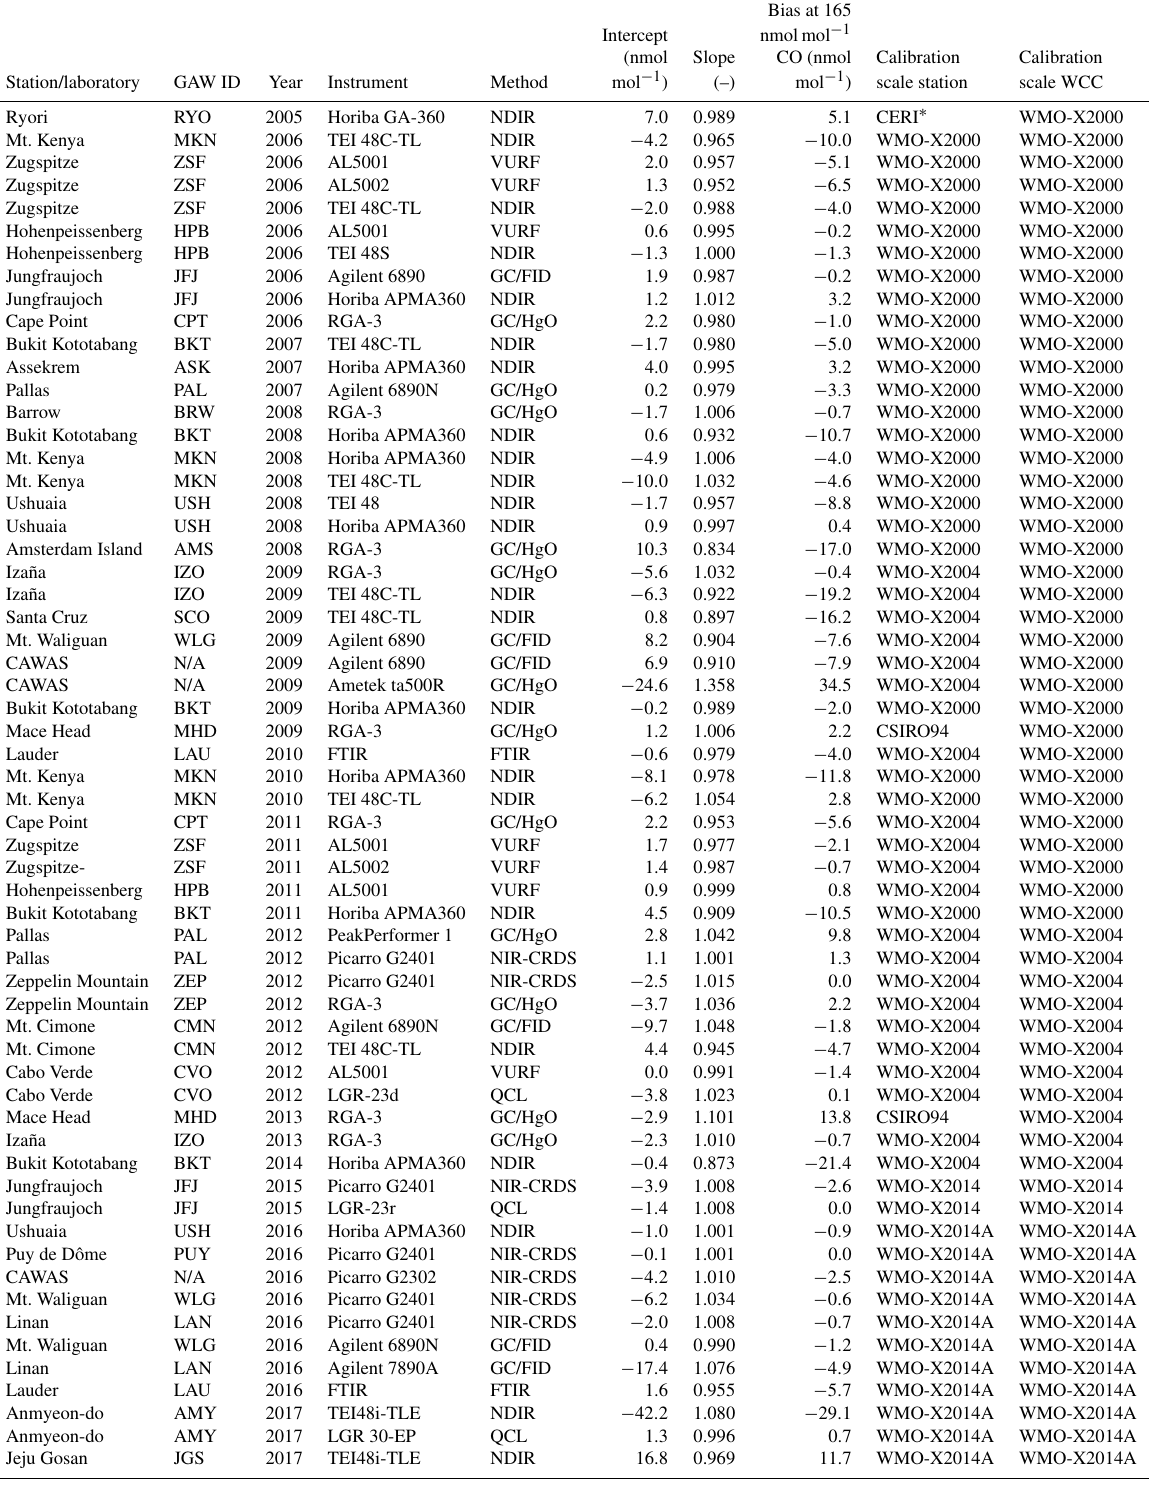
Table 1. CO performance audits using travelling standards from 2005 to 2017. Please note that CSIRO in the table refers to the Common- wealth Scientific and Industrial Research Organisation